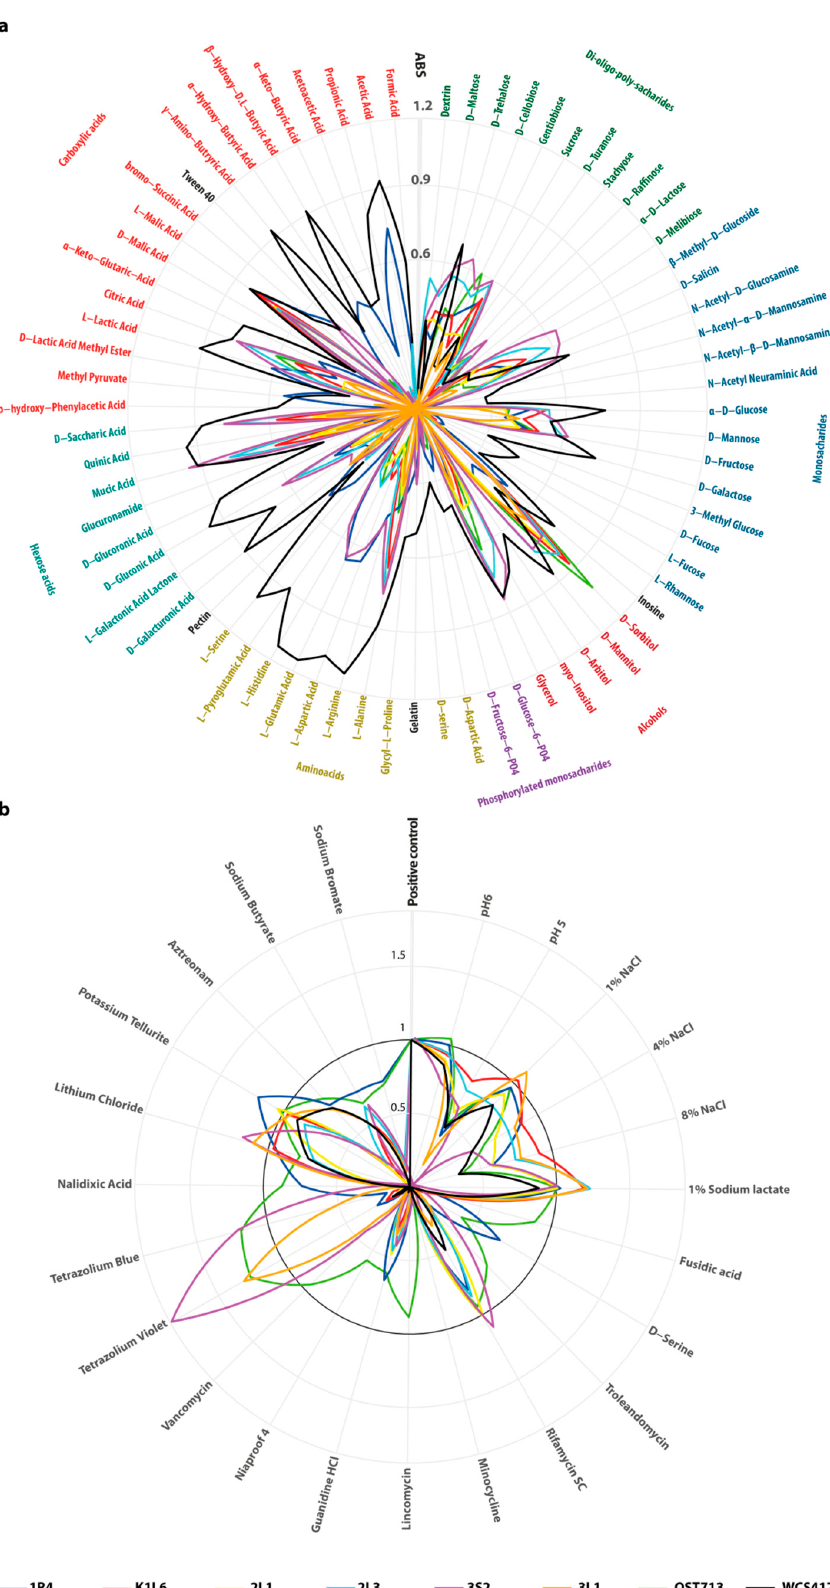
Figure 2. Biolog GEN III physiological analysis of selected endophytic bacteria from rapeseed and reference PGP strains. ( a ) Substrate utilization in absorbance unit, ( b ) relative growth (positive control is 1) of isolates in inhibition testing wells of a Biolog plate.